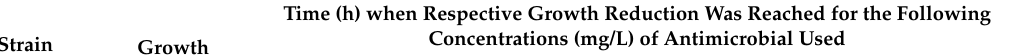
Figure 3. Time-kill curves of oxacillin shown by plots of mean values for the log 10 of the numbers of CFU/mL versus time for two representative clinical S. aureus WTs ( a , c ) and corresponding SCVs ( b , d ) tested against oxacillin. The threshold implicates a ≥ 3 − log 10 decrease in CFU/mL. Time-kill curves for each strain were performed in triplicate (mean ± standard deviation). Asterisks denote statistical difference of the respective concentration of oxacillin used (defined by matching colors) with respect to the untreated growth control at 1 h; p ≤ 0.001 by one-way ANOVA. Table 3. Times to achieve 50%, 90%, and 99.9% reductions in growth from starting inoculum when HY-133 or oxacillin was